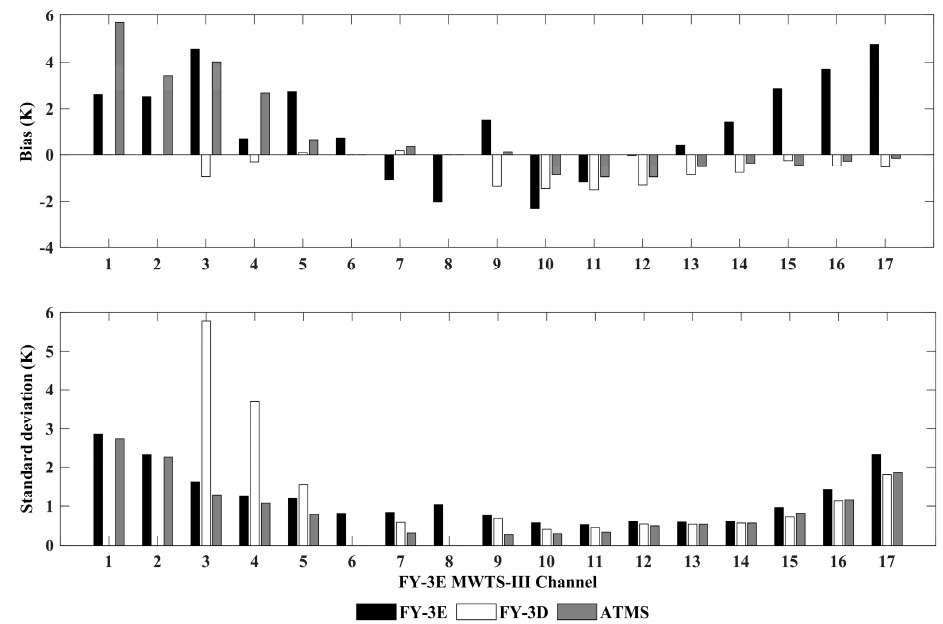
Figure 4. Comparison of O − B bias and standard deviation of equivalent channels of FY-3E MWTS-III (black), FY-3D MWTS-II (white) and ATMS (gray). x-coordinate is the channel number of FY-3E MWTS-III. The simulated values are obtained from the simulation of FNL data.